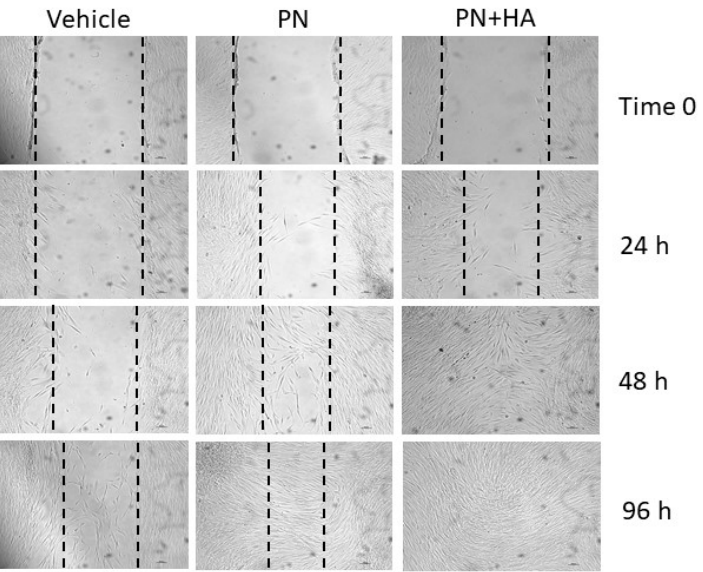
Figure A2. Microphotographs of gingival fibroblasts, after scratch, cultured with vehicle, PN or PN + HA immediately after scratch (Time 0) and after 24, 48 or 96 h, at phase interference microscopy. Magnification 4×. The vertical dashed lines represent the edges of the scratch.